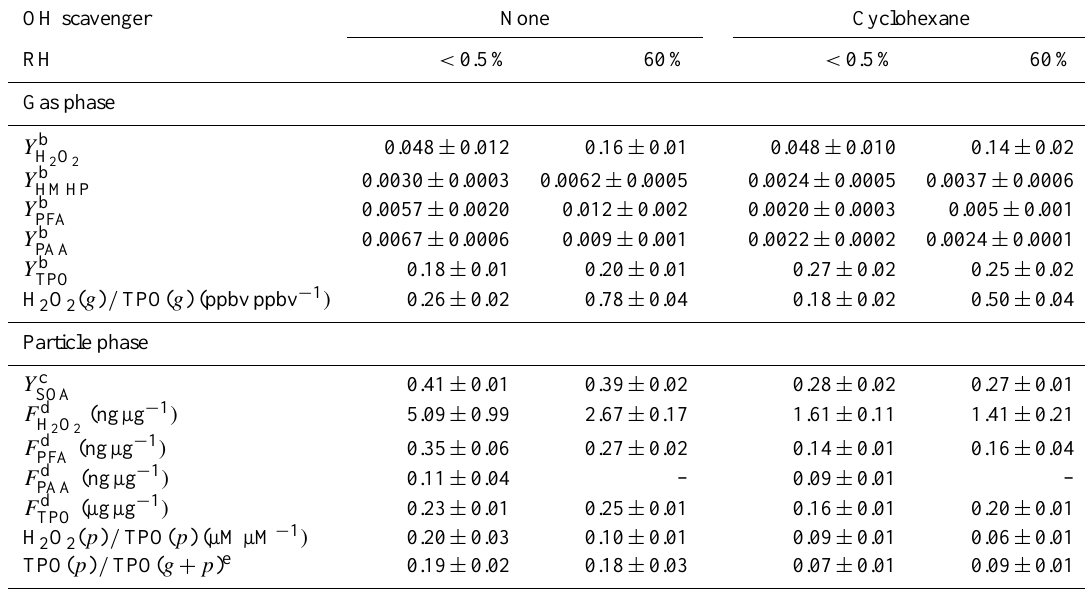
Table 1. Peroxide content in the gas phase and particle phase of α -pinene ozonolysis as affected by the OH radical scavenger cyclohexane a . OH